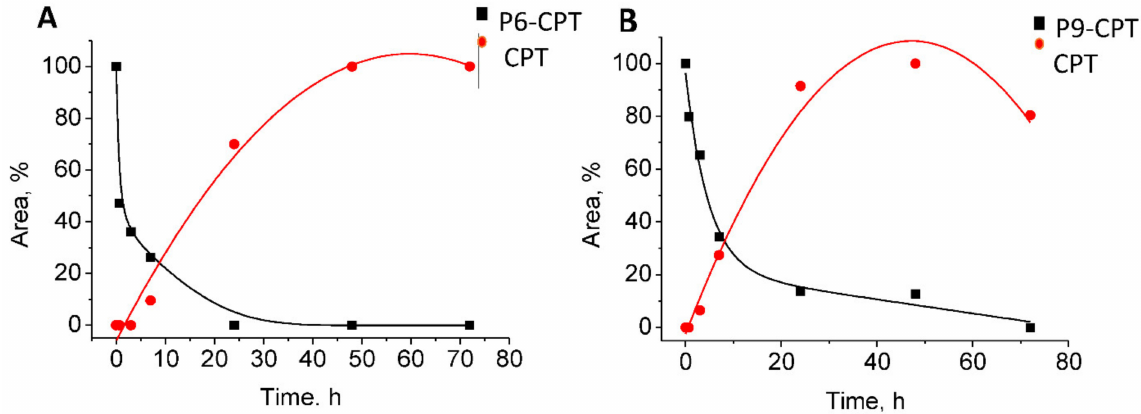
Figure 8. CPT release profiles for P6-CPT and P9-CPT peptide drug conjugates . Peptide conjugates were incubated at 37 ◦ C in a complete growth RPMI medium for 0.5, 3, 7, 24, 48, and 72 h. ( A ) peptide 6 ( B ) peptide 9. The integrity of the conjugates was measured by mass spectrometry. Each measurement was performed in triplicate.